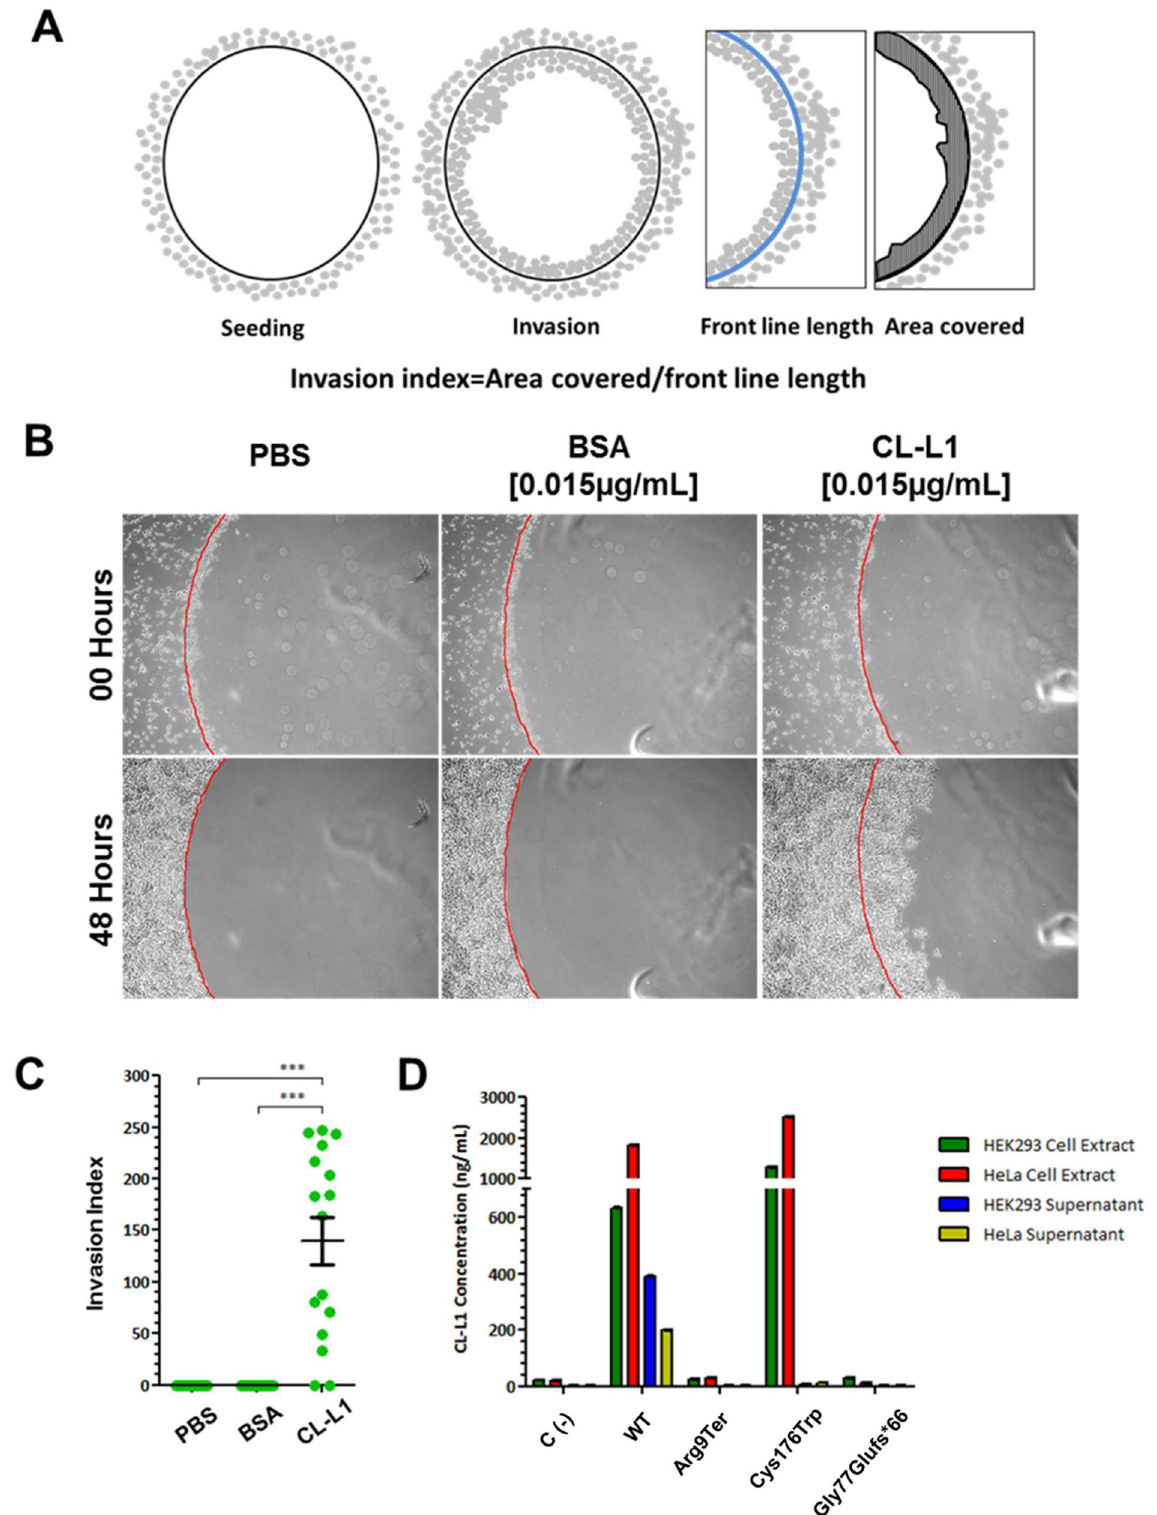
Fig 3. CL-L1 regulates cell migration and act as migratory chemoattractant. A. Experimental design for cell migration assay and invasionrate. Agarose spots containing CL-L1 and/or CL-K1 were attached to the glass and HeLa cells seeded.After 24 hours pictures were taking on different spots. The area coveredinside the spot by the cells (advancefront) was measuredand normalised for the length of the perimeter of the spot. B. Representative pictures of agarosespots containingPBS, BSA and CL-L1 with